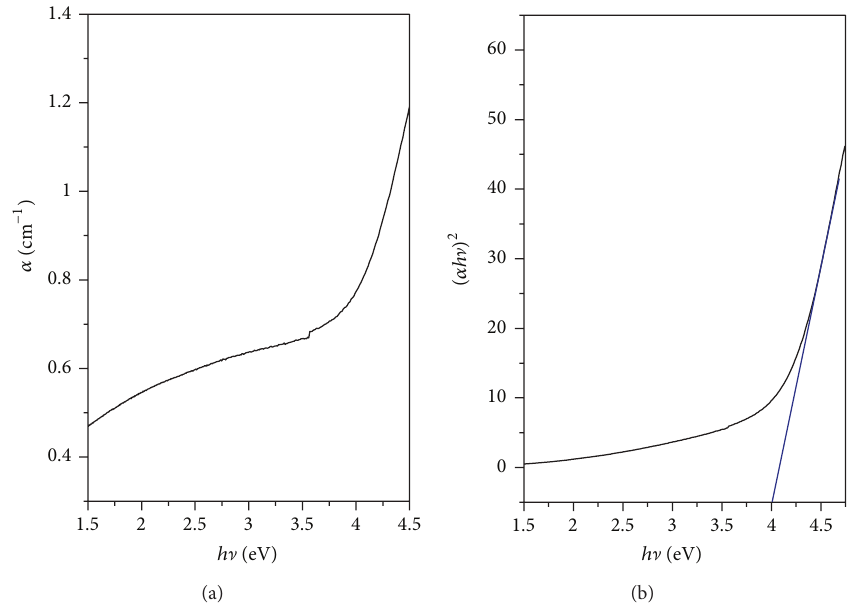
Figure 6: (a) Variation of alpha with photon energy and (b) Tauc’s plot of nano-BaWO 4 .